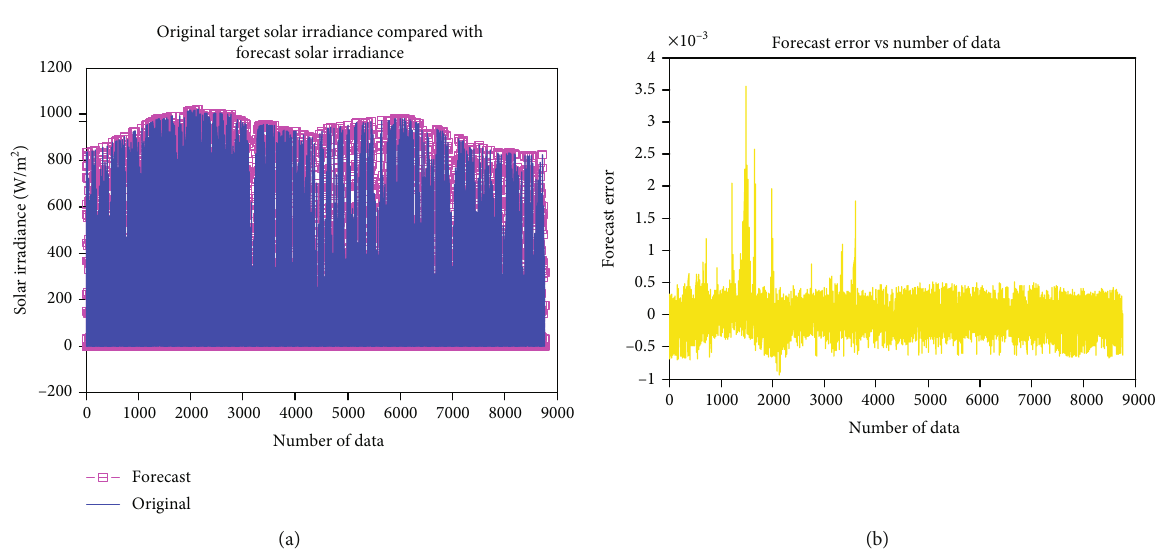
Figure 11: (a) Four input MLPNN-based forecasting model original targets compared to forecast solar irradiance. (b) Four input MLPNN- based forecasting model forecasting errors vs. the number of data